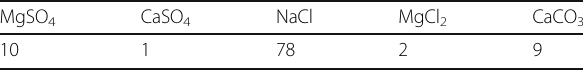
Table 1 The components of the salt mixture used for chloride salinization expressed as % of the total salt